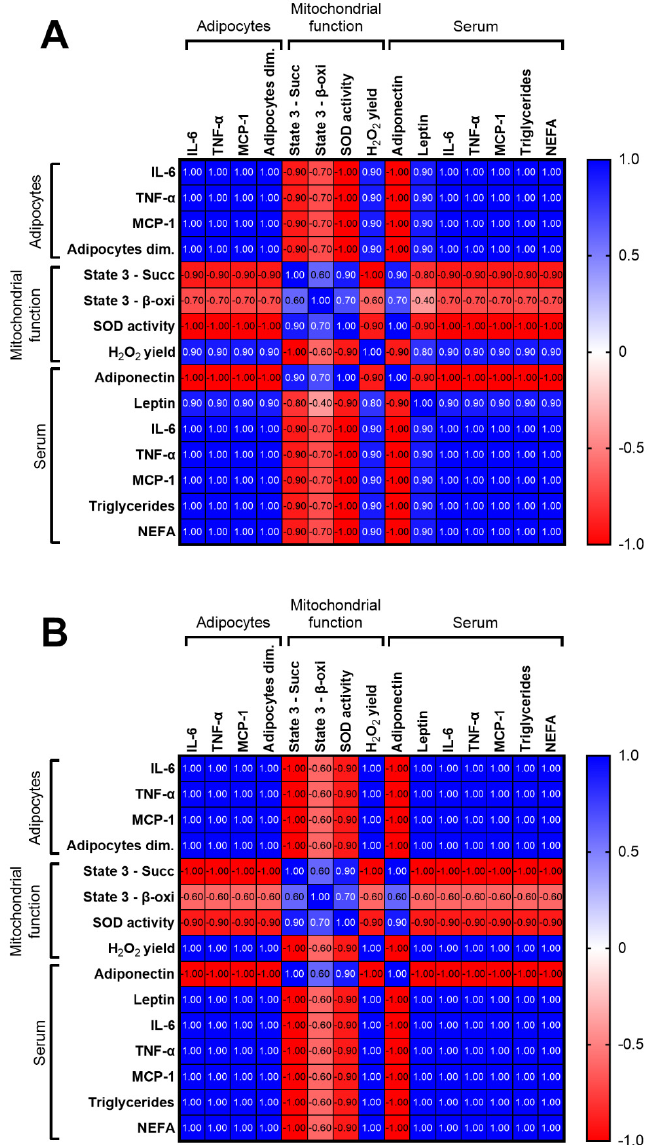
Figure 7. Spearman’s correlation between mitochondrial function parameters, serum dyslipidemia indicators, serum, and adipocytes inflammatory markers in control ( A ) and high-fat diet ( B ) with age.